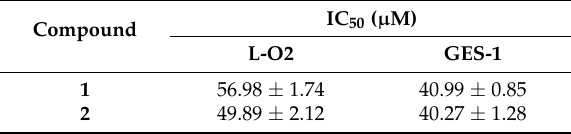
Table 4. Cytotoxicity of compounds 1 and 2 against two human normal cell